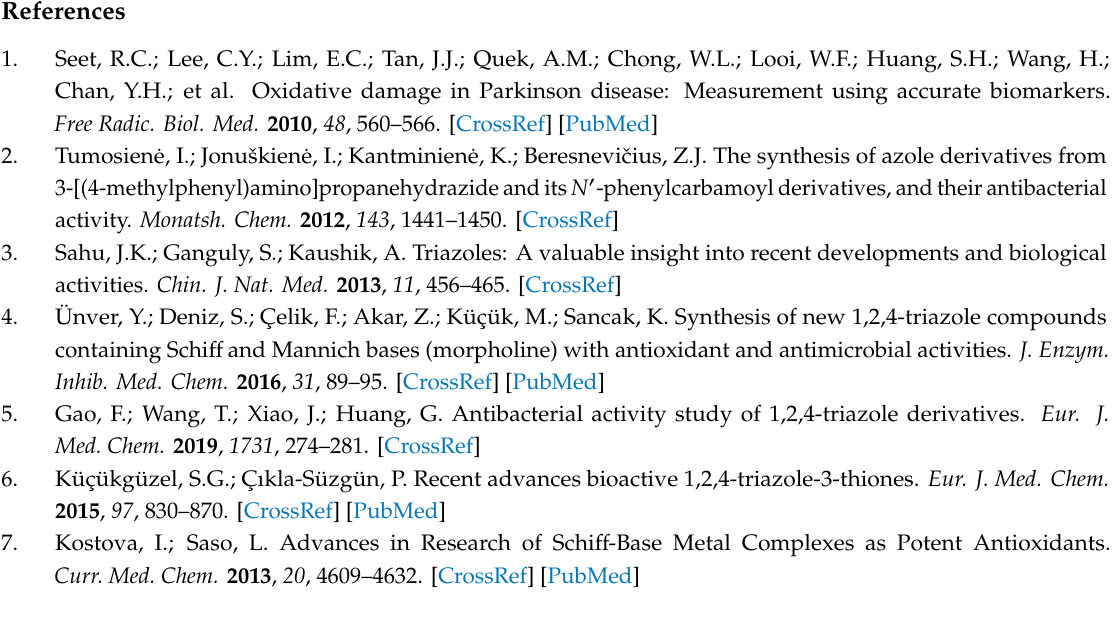
Supplementary Materials: The following are available online, Figures S1–S120 display 1 H-NMR, 13 C-NMR, and HRMS spectra of compounds 2 – 39